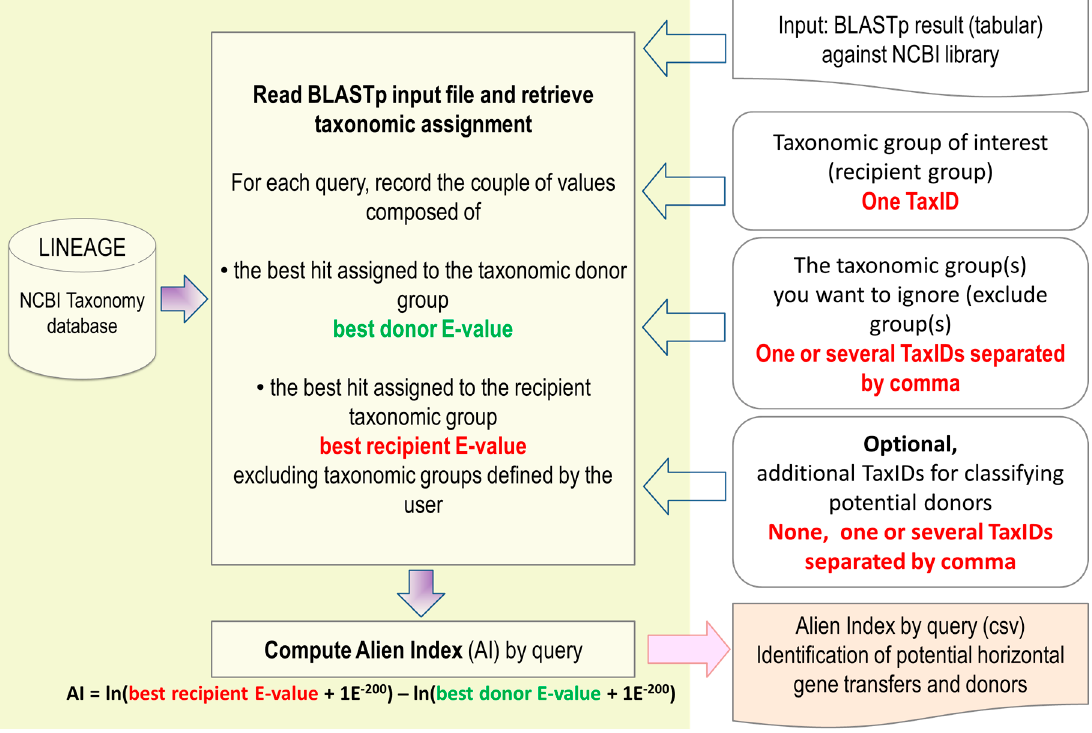
Figure 1. Schematic flow chart of Alienness processing BLAST results and providing Alien Indexes (AIs). NCBI: National Center for Biotechnology Information; TaxID: taxonomy